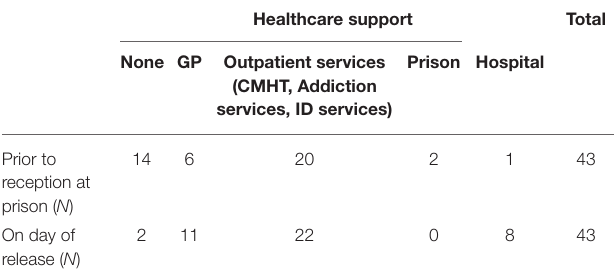
TABLE 3 | Comparison of level of healthcare support at time of reception to prison with that on day of release, following the intervention of the PReP Programme ( N =